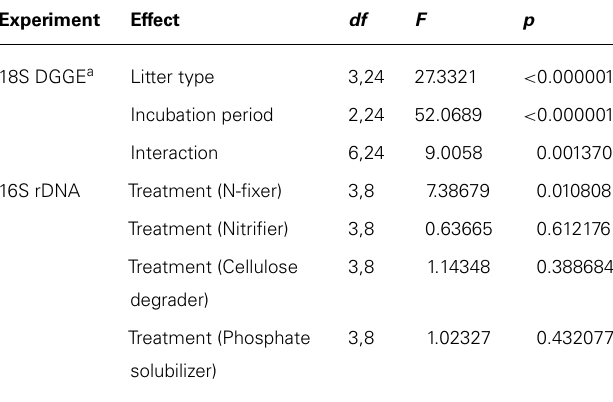
Table 2 | Summary of results for statistical tests used in analyses of variance for poplar litter